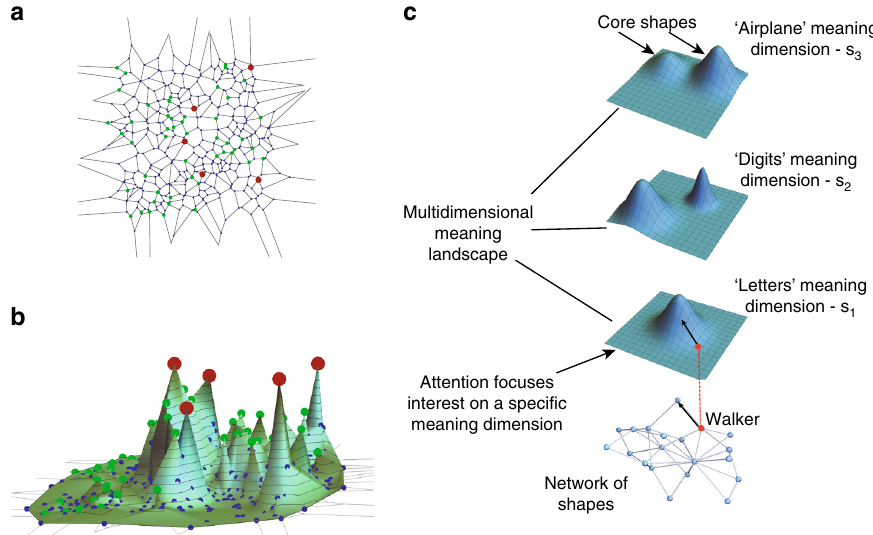
Fig. 2 Players ’ dynamics induces multi-layered meaning landscapes. a A searcher walks on the network of shapes. The network of shapes consists of core shapes (marked in red), gallery shapes (marked in green) and all other shapes (marked in blue). Shapes are connected by one move of a square. b The meaning landscape built on top of the network of shapes. Close by core shapes typically belong to different meaning categories. c The meaning landscape is composed of a multi-layered space of meaning dimensions. Each shape has M dimensions of meaning, corresponding to M meaning landscapes which show high meaning for shapes in the core of the corresponding category ( ‘ airplanes ’ , ‘ digits ’ , ‘ letters ’ etc … ). The attention vector focuses the searcher to do hill-climbing along a speci fi c meaning